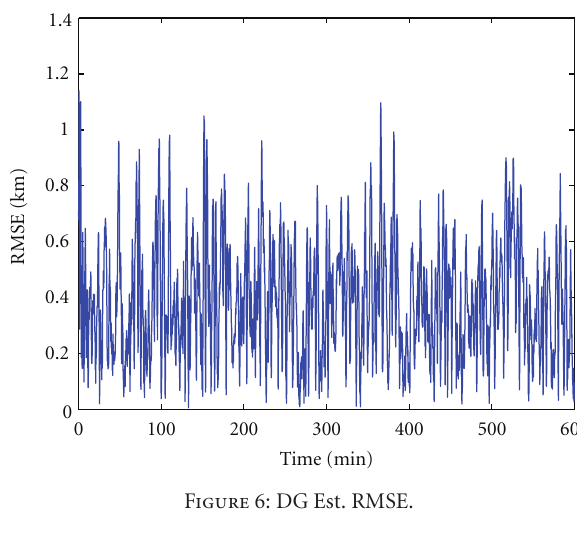
Figure 6: DG Est. RMSE.